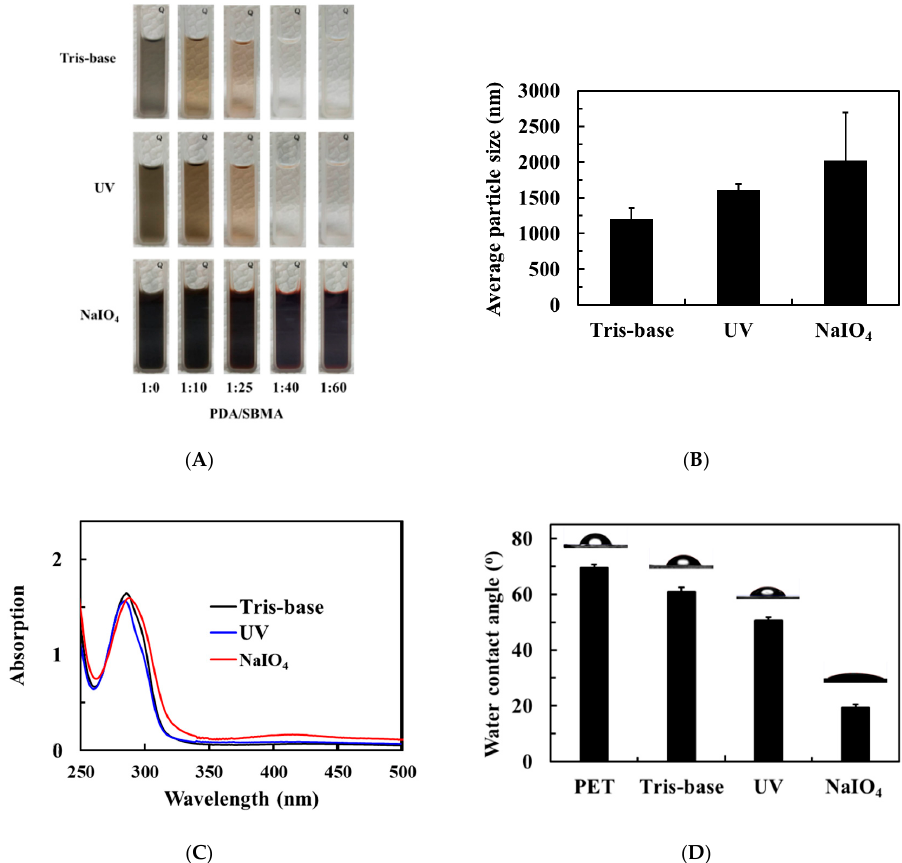
Figure 1. ( A ) Color changes of the various PDA / SBMA solutions in tris-base solution (pH = 8.5) with UV light and NaIO 4 trigger. ( B ) Particle size and ( C ) UV-VIS spectra of PDA (2 mg / mL) solution at 2 h with UV light and NaIO 4 trigger. ( D ) Water contact angles (WCAs) of the PDA coating on a polyethylene terephthalate (PET) substrate with UV light and NaIO 4